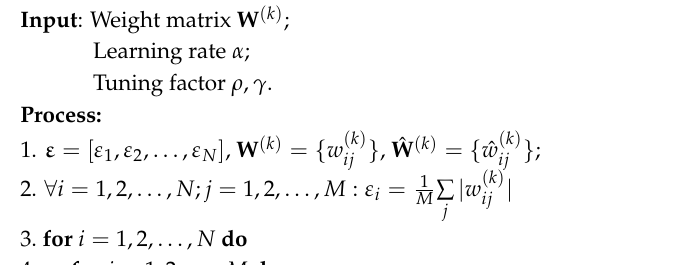
Figure 9. The framework of RRBM. Algorithm 1. The reinforcement algorithm on W ( k ) in RRBN.